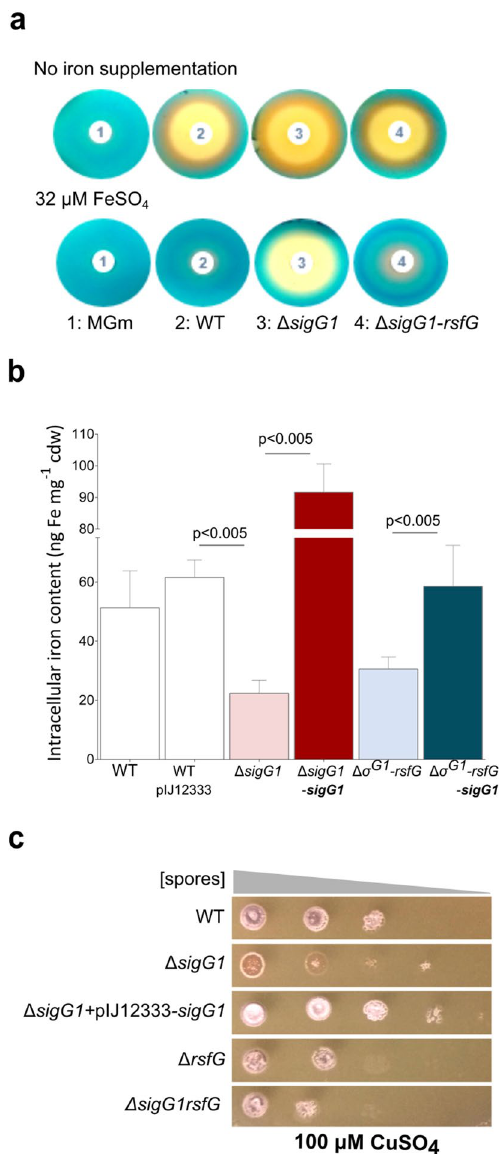
Figure 5. Evaluation of metal-ion homeostasis in sigG1 mutants . ( a ) Chrome azurol S (CAS) assay to determine siderophore secretion in the supernatants of strains grown in iron limiting and iron-sufficient conditions (FeSO 4 32 μM) conditions. ( b ) Intracellular iron content in S. tsukubaensis wild-type, Δ sigG1 , Δ rsfG - sigG1 and respective complemented strains measured by flame atomic spectrometry (F-AAS). Values are representative of at least three independent experiments. ( c ) Phenotypes of the wild-type, sigG1 and rsfG-related strains grown on solid ISP4 supplemented with 100 µM CuSO 4 medium for 6 days. Serial dilutions used were 10 5 , 10 4 , 10 3 , 10 2 , 10 1 spores. Statistically significant differences were determined by one-way ANOVA followed by a Dunnet’s test (GraphPad